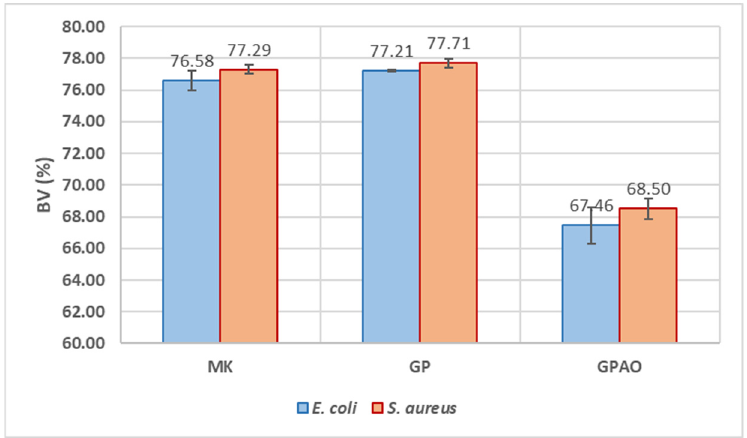
Figure 10. BV (%) of MK, GP, and GPAO assayed in the presence of E. coli and S. aureus .